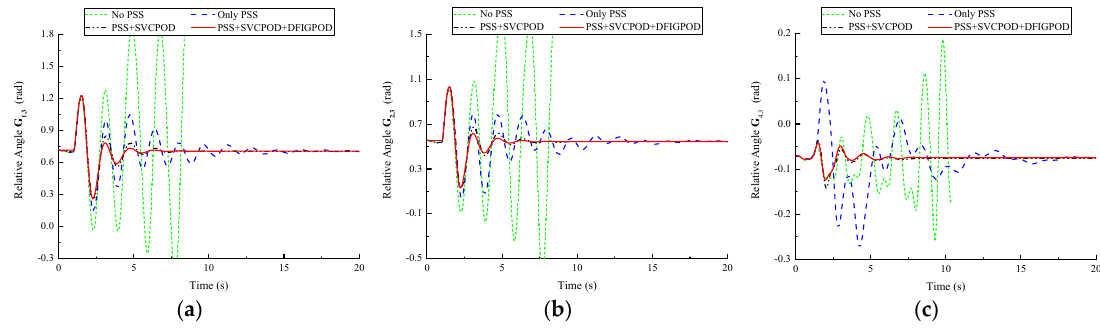
Figure 12. System bus 7 3-phase fault responses under heavy inter-area power flow transmission condition. ( a ) Relative power angle of generator G1 and G3; ( b ) Relative power angle of generator G2 and G3; and ( c ) Relative power angle of generator G4 and G3.